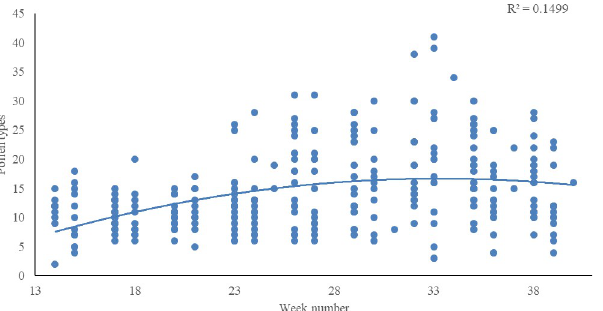
Fig 1. Number of different pollen types present in multiple pollen samples from across Denmark as a function of week number 14 to 40 (C.S.I. data merged for 2014 and 2015). A polynomial trend line (R 2 = 0.1499) for the data is